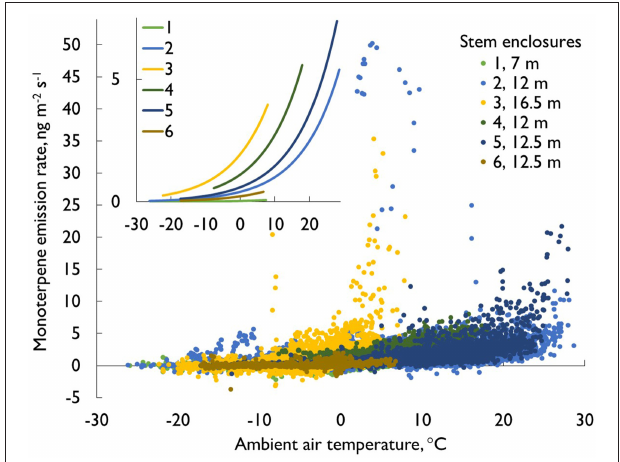
FIGURE 5 | The monoterpene emission rates (ng m − 2 s − 1 ) from pine stems as a function of the ambient air temperature. The data originate from all six stem enclosures and cover all seasons (26 429 measurement points in total, April 2012–August 2015). The insert gives the exponential lines for each enclosure separately.